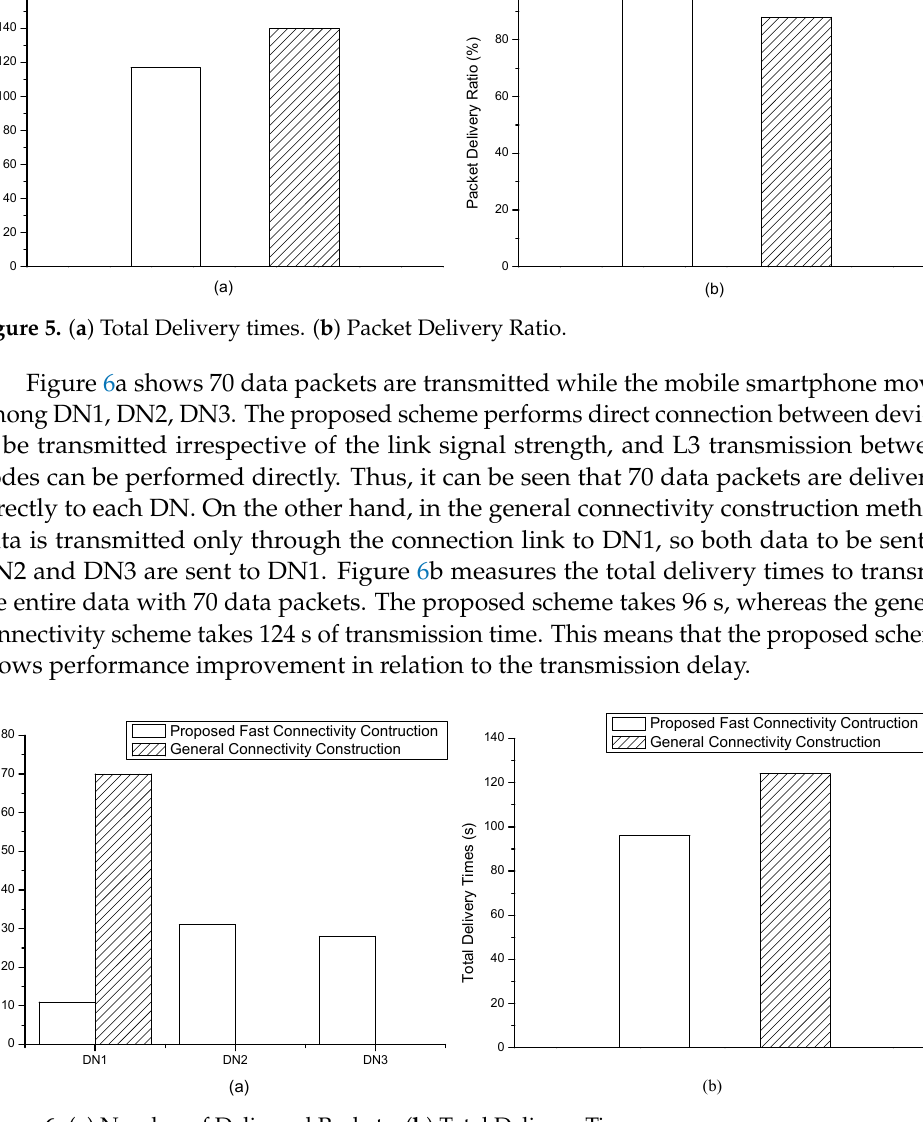
Figure 6. ( a ) Number of Delivered Packets. ( b ) Total Delivery